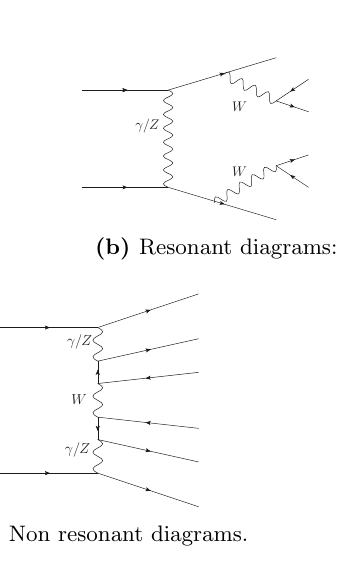
Figure 1. Representative diagrams for WW